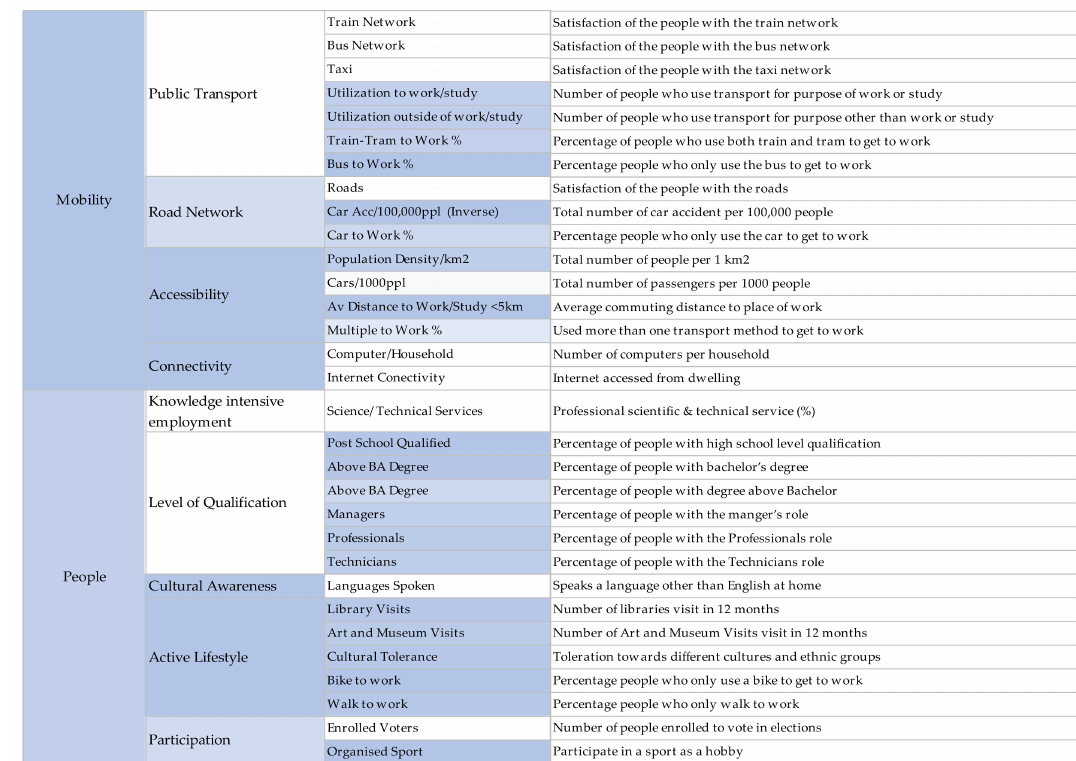
Figure 2. Selection of Components, Factors, and Indicators for evaluation (AHP weightages applied at each level, shade intensity shows lower weightage).